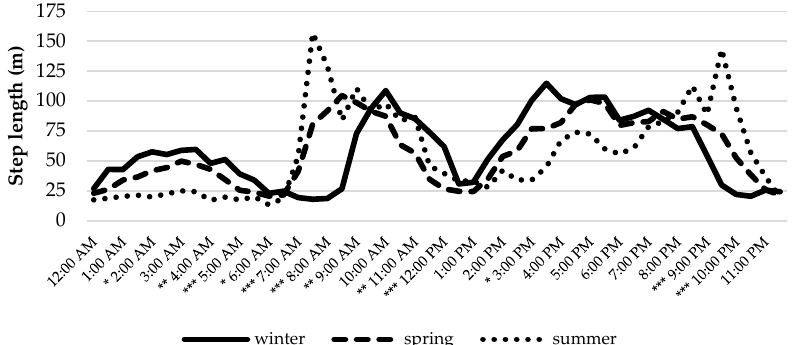
Figure 6. Seasonal variability of the daily activities of cattle. Asterisks indicate statistical significance: * = p < 0.05; ** = p < 0.01; *** = p < 0.001.